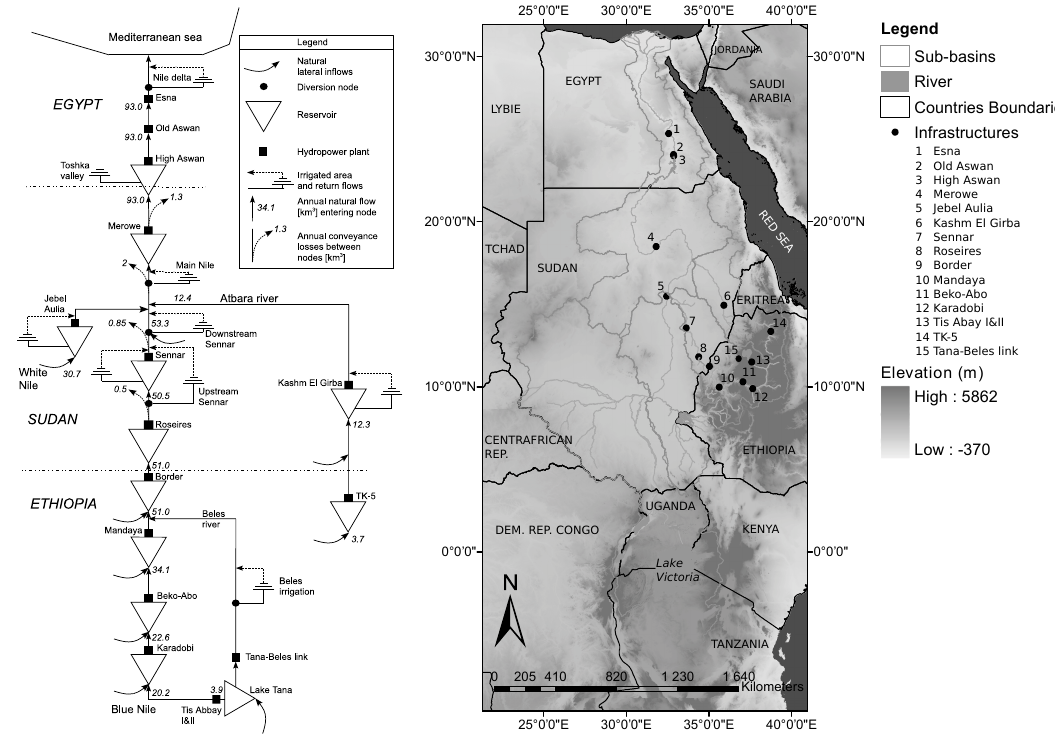
Fig. 2. Topological view of the Eastern Nile River Basin hydro-system.